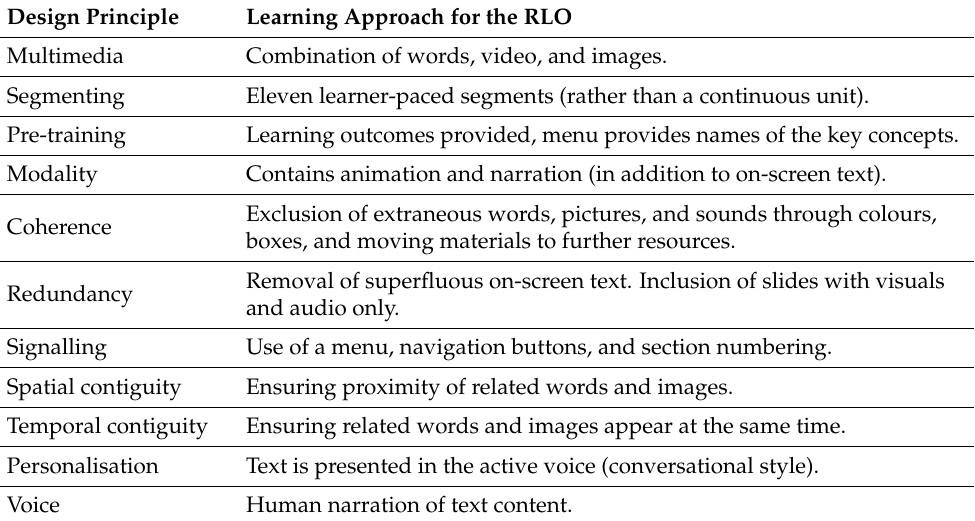
Table 1. Mapping of design principles to RLO design